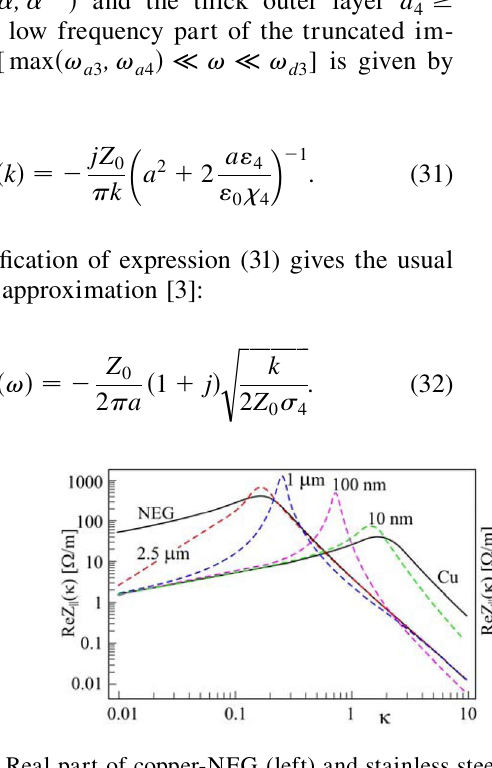
FIG. 2. (Color) Real part of copper-NEG (left) and stainless steel-copper (right) tube impedances for various cover